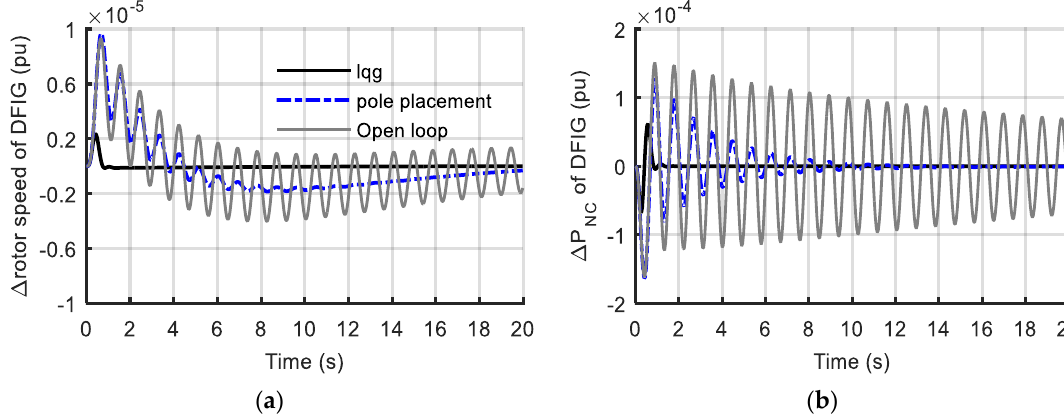
Figure 10. DFIG performance due to 0.05 pu step load demand at P = 1.0 pu, Q = 0.25 pu. ( a ) DFIG rotor speed deviation; ( b ) DFIG power output deviation.